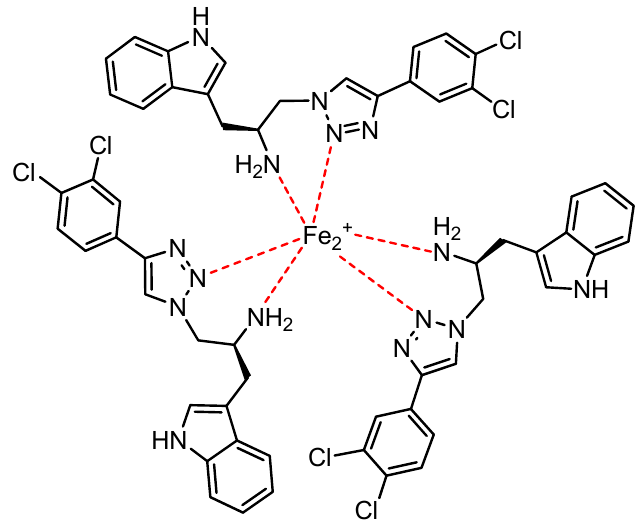
Figure 6. The chelating model of compound 12c with Fe 2+